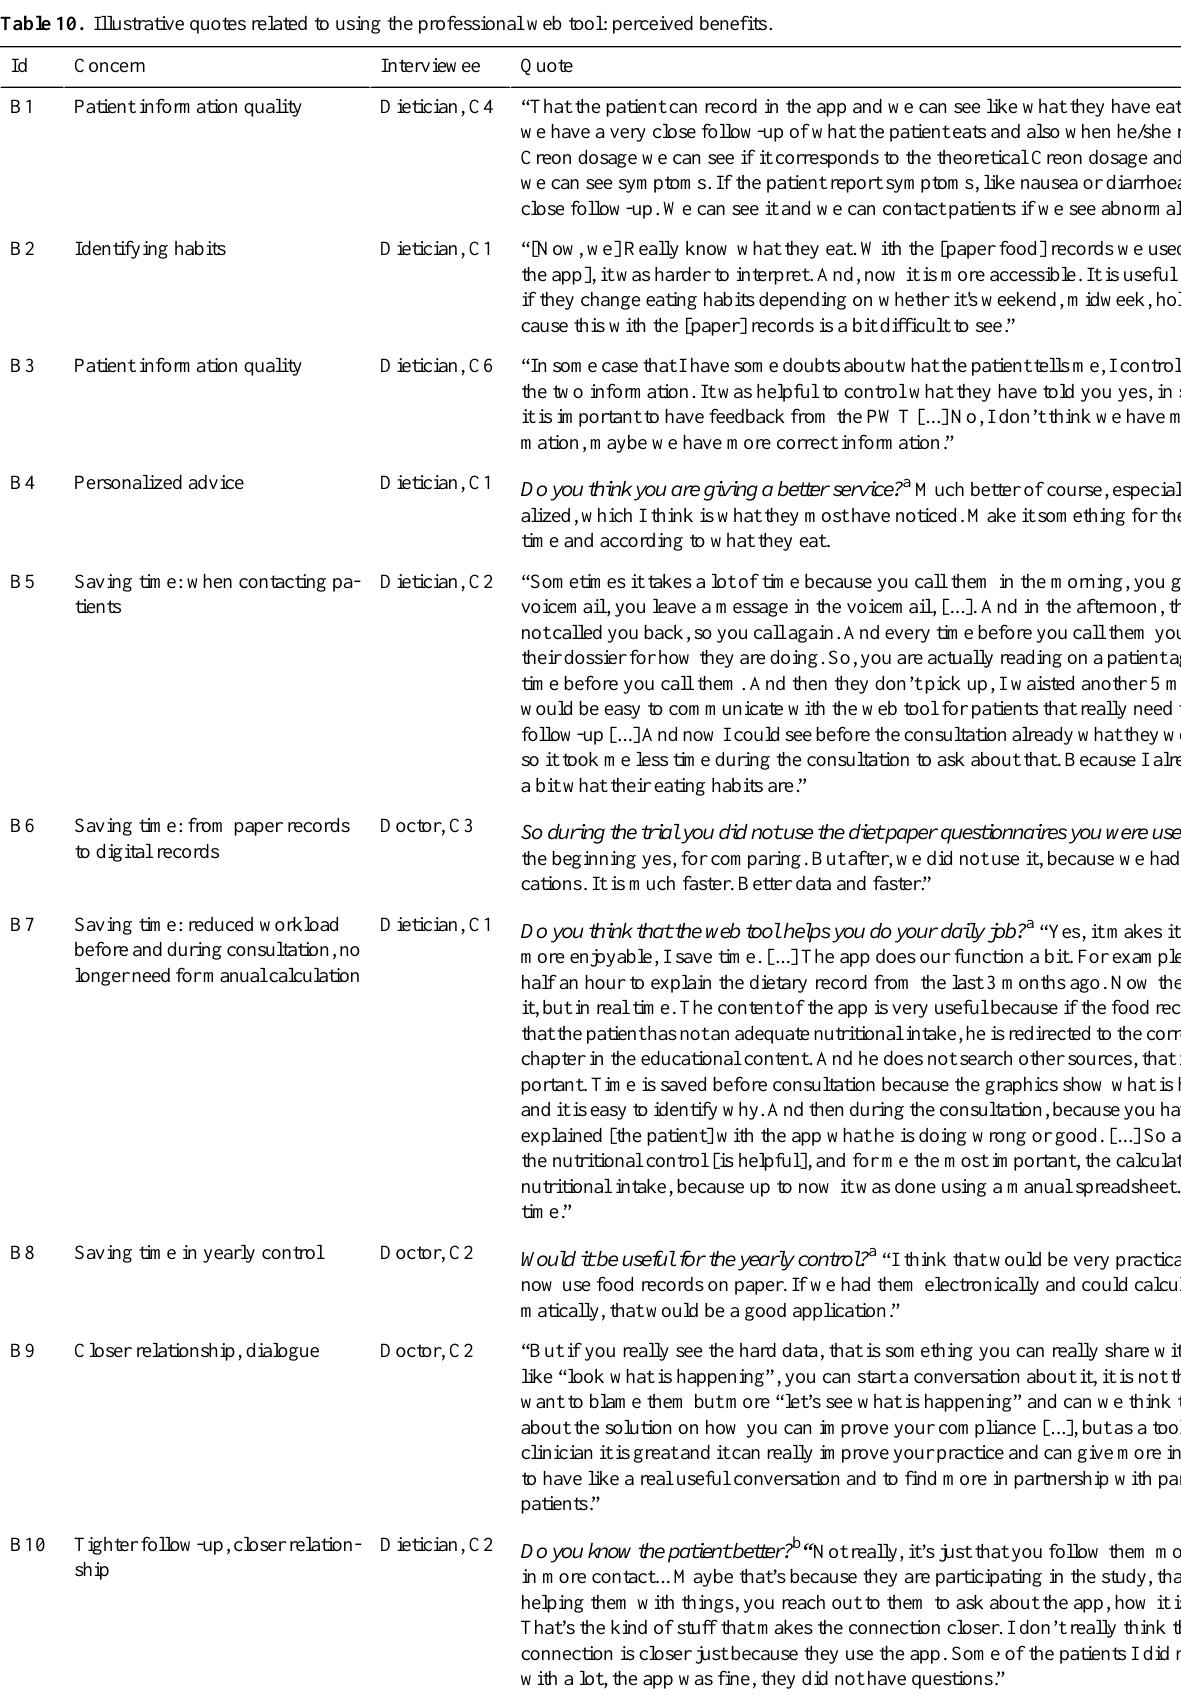
Table 10. Illustrative quotes related to using the professional web tool: perceived